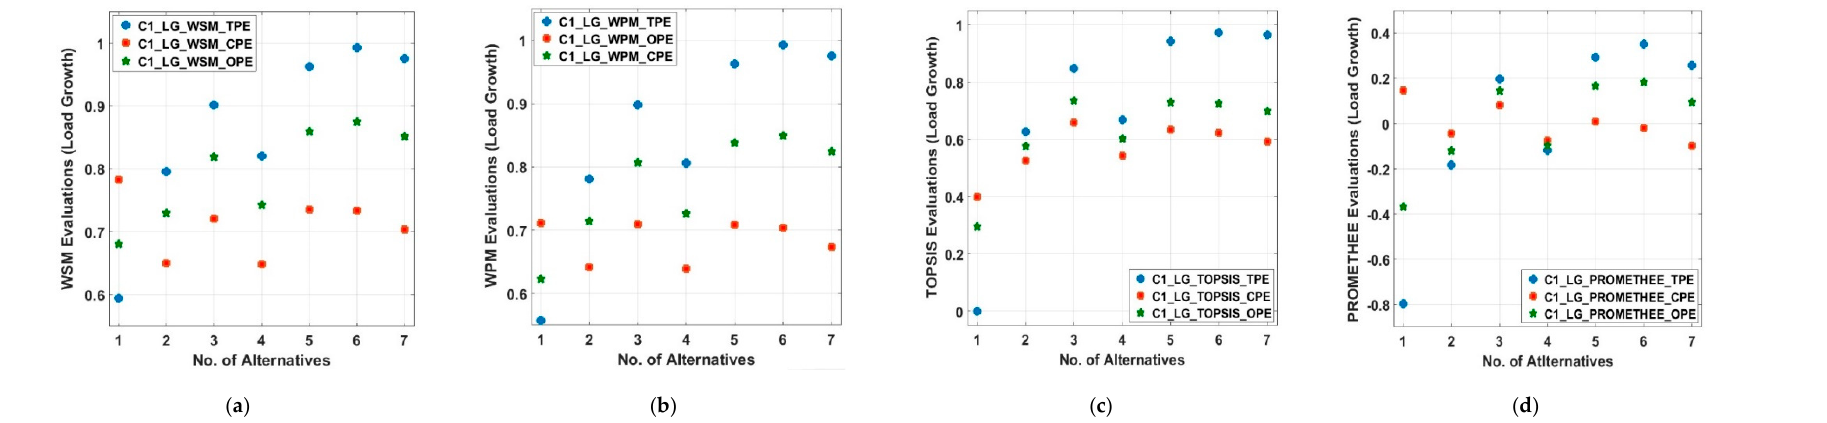
25 of 51 Table 13. Techno-economic evaluation analysis in case 1 (C1_LG) for 33-bus MDN. S#: Technical Parameters Evaluations (TPE)